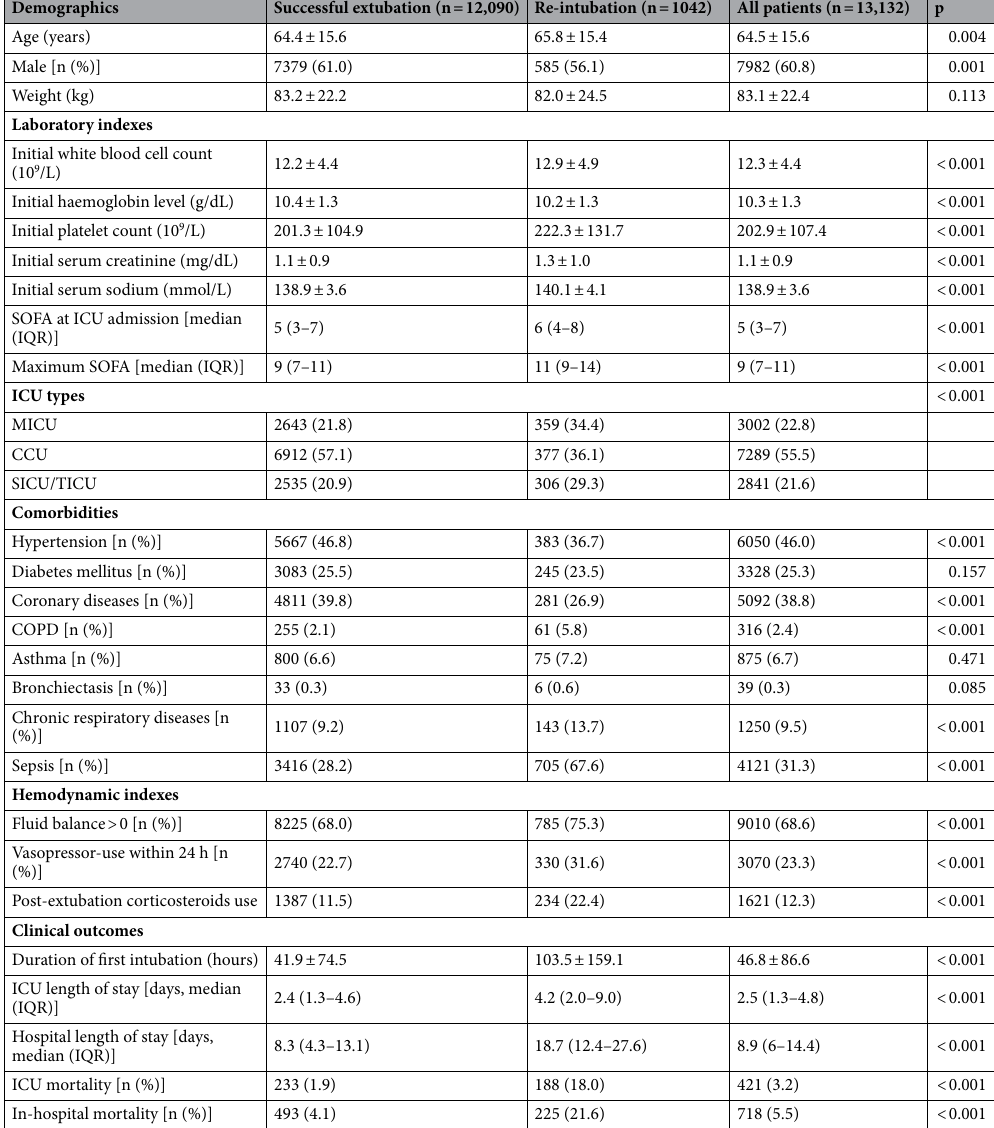
Table 1. Baseline comparisons between successful extubation and re-intubation groups. SOFA sequential organ failure assessment, MICU medical intensive care unit, CCU including coronary care unit and